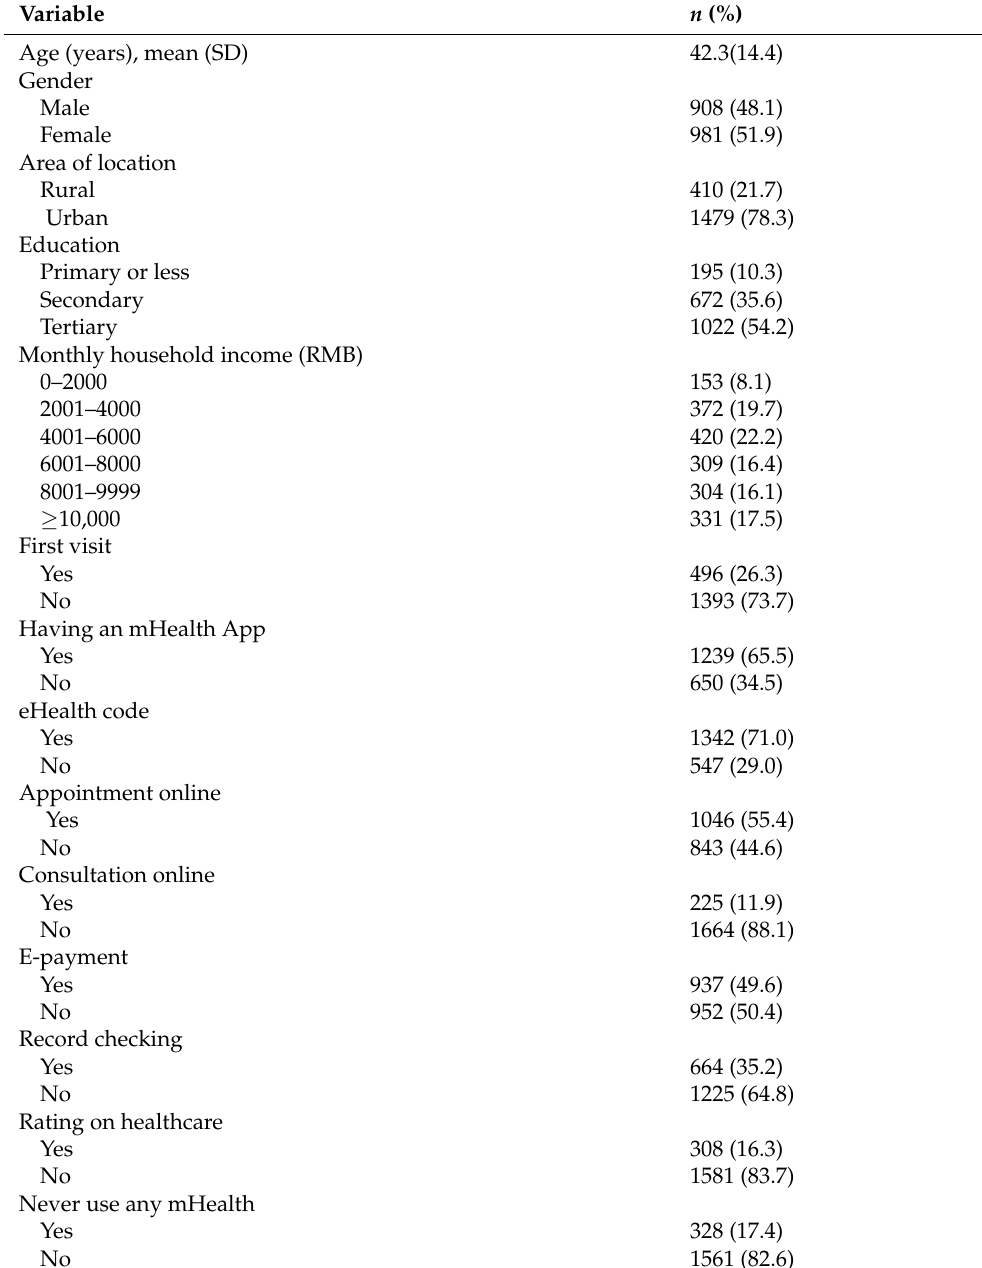
Table 1. Sociodemographic characteristics of participating